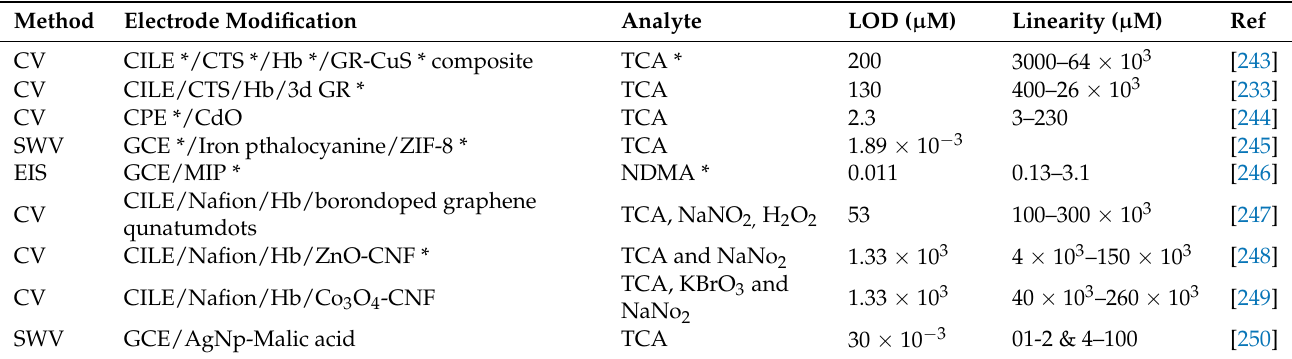
Table 7. Electrochemical sensor for the detection of disinfectant in